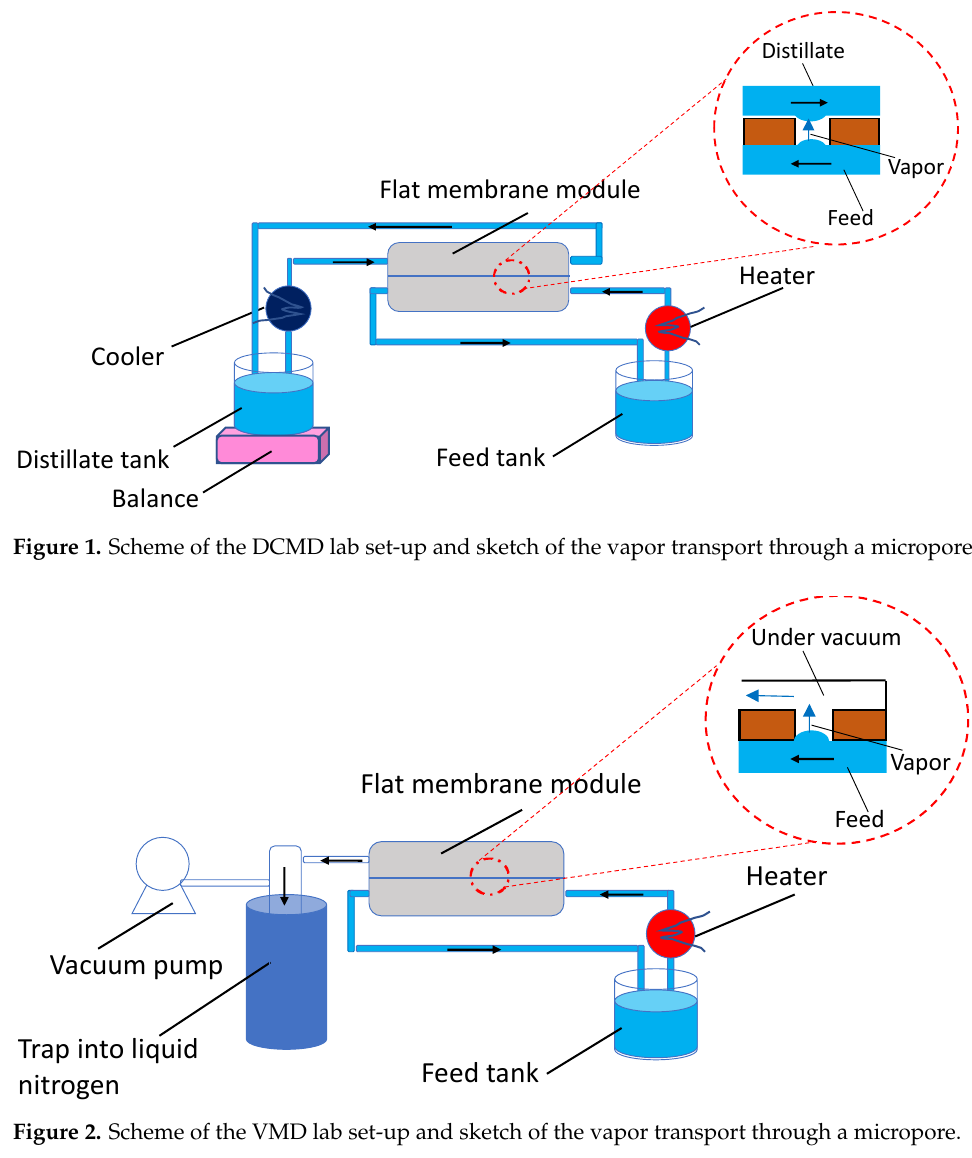
Table 2. Main operating conditions used during DCMD and VMD tests.